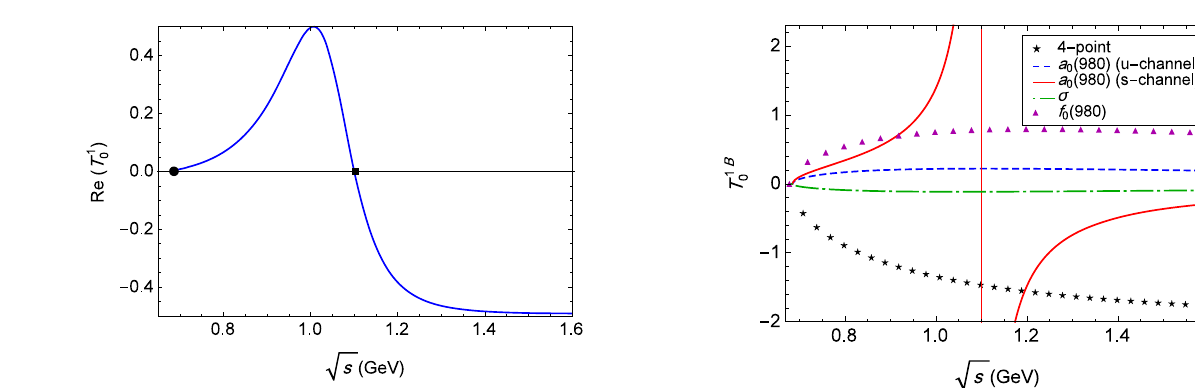
Fig. 3 Individual contributions to the πη scattering in the single nonet